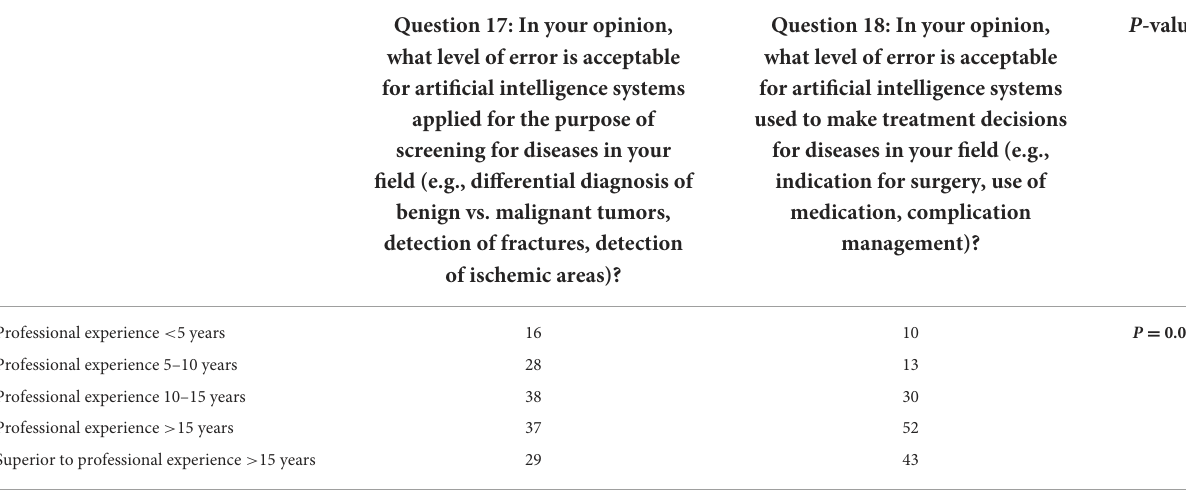
TABLE 2 Comparison of the acceptable level of error for an AI tool used for disease screening (question 17) and treatment decision support (question 18).